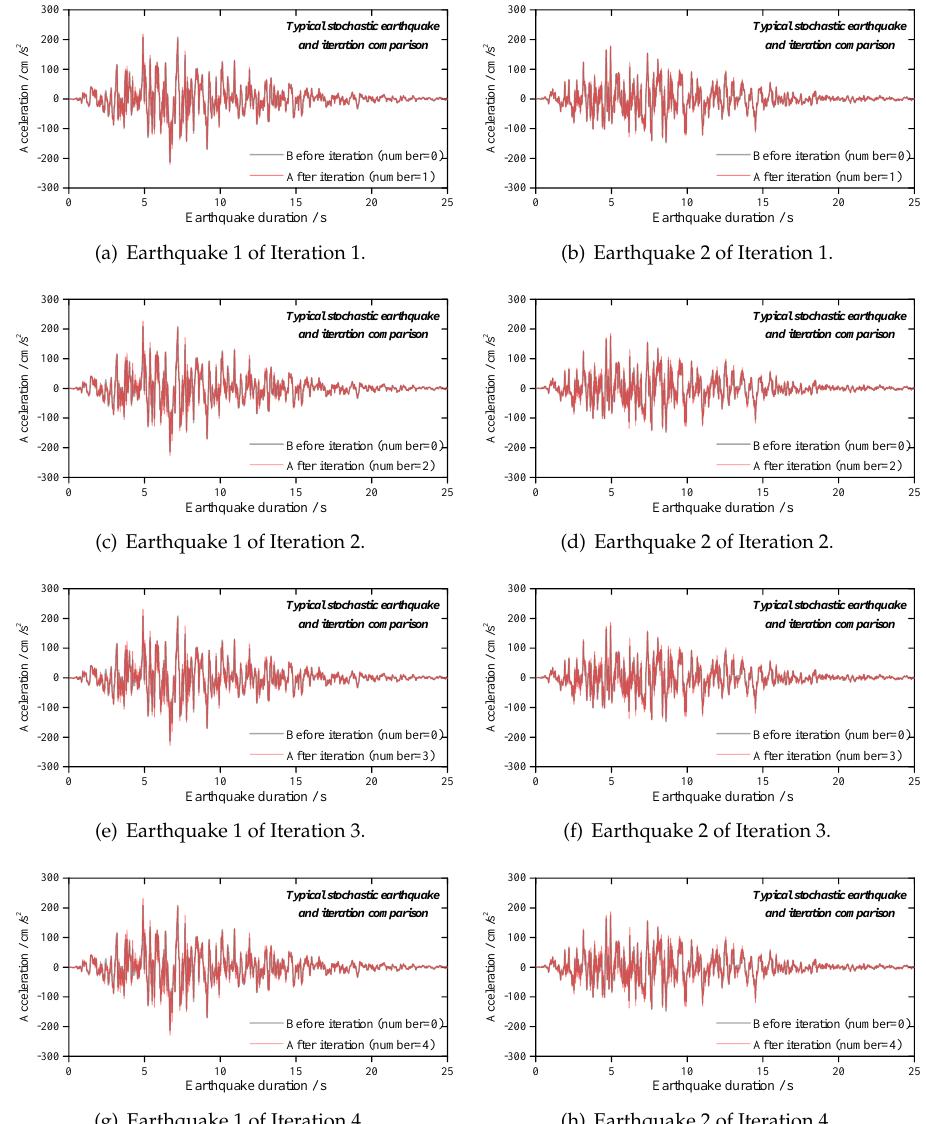
Figure 7. The typical stochastic earthquake and iteration comparison via the iterative PSD- based